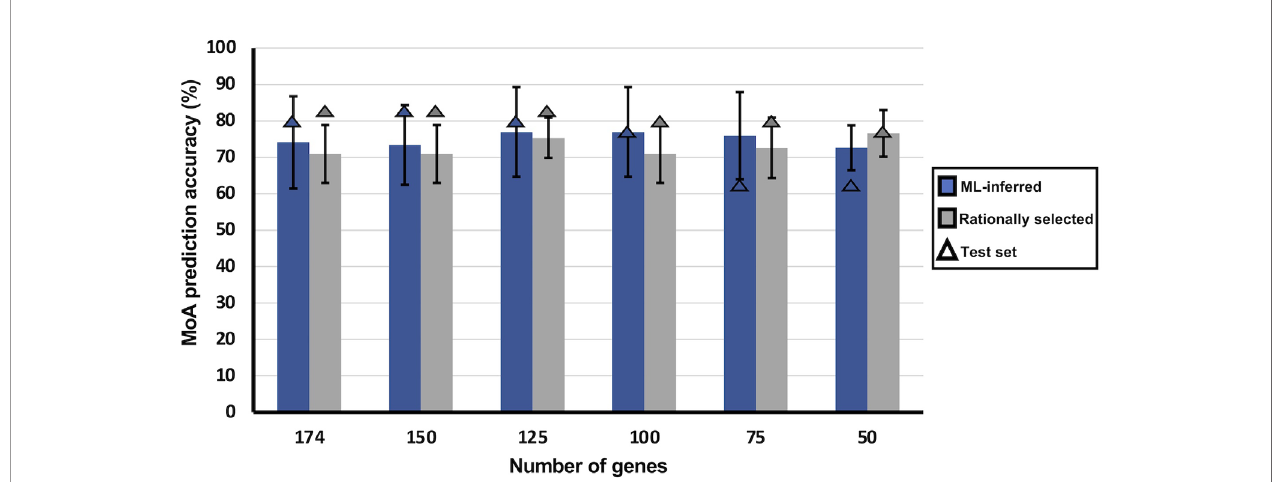
FIGURE 3 | In fl uence of limiting the number of transcripts used as training features on MoA strati fi cation of MLR models. MLR classi fi ers trained on either ML- inferred transcripts (blue) or on rationally selected transcripts (light gray). Using variable importance, transcripts were ranked according to their importance in making classi fi cation decisions for the MLR classi fi er. With the ranked transcripts a sliding gene-scale approach was applied where the top transcripts were used to make minimodels with each sequential model containing decreasing number of transcripts used to train the MLR classi fi er. Each minimodels underwent 10-fold cross- validation and was also assessed in the accuracy of MoA strati fi cation on test data. Bars indicate average accuracy obtained from 10-fold cross-validation, and triangles indicate model accuracy on the untrained test set. Error bars indicates the standard deviation of the average